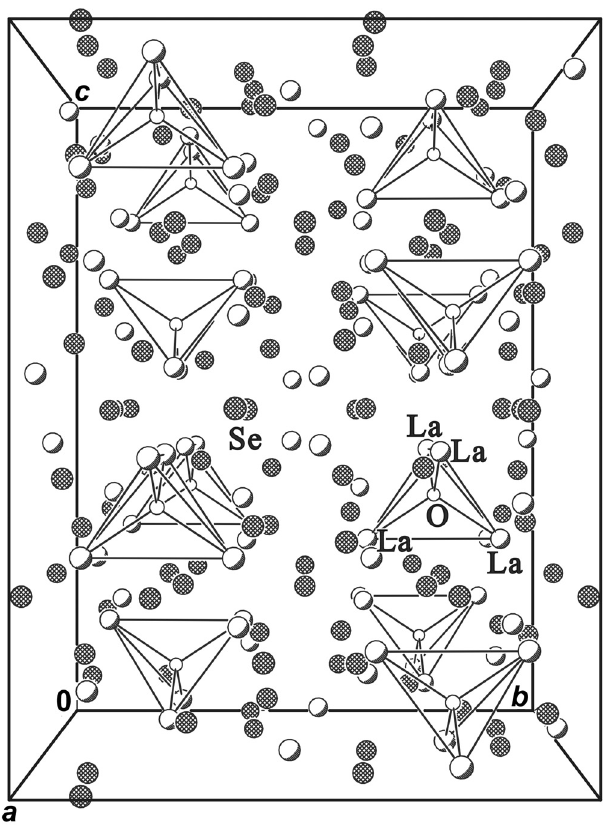
Table 1. Data collection and